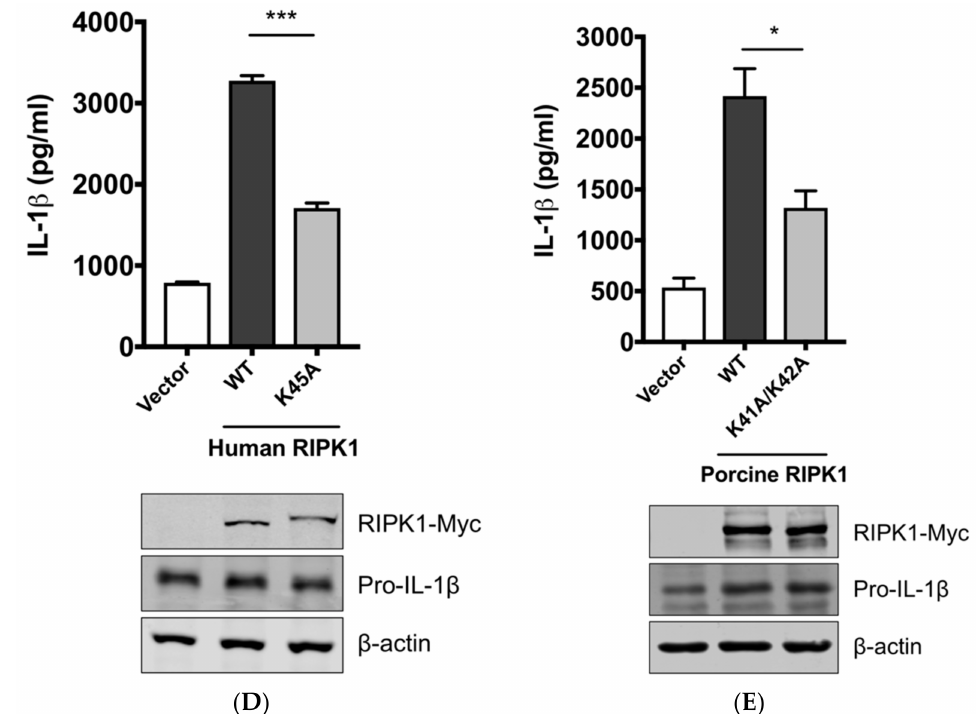
Figure 4. The SIV-induced IL-1 β production requires receptor-interacting protein kinase 1 (RIPK1) kinase activity. ( A ) PAMs were transfected with a negative control siRNA (siControl) or RIPK1 -targeting siRNA (siRIPK1) for 24 h and infected with Sk02 at an MOI of 1 for 16 h. Porcine IL-1 β levels from supernatants were measured by ELISA. Expression of pro-IL-1 β was analyzed by Western blotting. RIPK1 knockdown efficiency was determined by real-time PCR. ( B ) PAMs were infected with Sk02 at an MOI of 1 for 20 h in the presence of a vehicle (DMSO) or increasing concentrations (80 and 160 µ M) of RIPK1 kinase inhibitor, Nec-1. Porcine IL-1 β levels from supernatants were measured by ELISA. Expression of pro-IL-1 β and viral NS1 was analyzed by Western blotting. ( C ) Amino acid sequences of the N-terminal ends of the kinase domains in porcine, murine, and human RIPK1 (based on the GenBank accession numbers XM_005665536, NM_009068, and NM_003804, respectively) were aligned using Clustal Omega. Amino acid positions are based on the human RIPK1 and asterisks indicate conserved residues among the three species. K41/K42 in porcine RIPK1, K45/K46 in murine RIPK1, and K45 in human RIPK1 are underscored. ( D ) For the NLRP3 inflammasome reconstitution assay, HEK293T cells were co-transfected with plasmids expressing porcine NLRP3 inflammasome components (NLRP3, ASC, and procaspase-1) and pro-IL-1 β along with Myc-vector or Myc-tagged WT/mutant human RIPK1 for 16 h. Porcine IL-1 β levels from supernatants were measured by ELISA. Protein expression was analyzed by Western blotting. ( E ) HEK293T cells were transfected as in ( D ) along with the Myc-vector or Myc-tagged porcine RIPK1 WT/mutant for 16 h. ELISA and Western blotting were done as in ( D ). Statistical analysis was done with one-way ANOVA except for the knockdown efficiency data done with an unpaired t -test. * p < 0.05; ** p < 0.01; *** p < 0.001. Results are representative of three independent